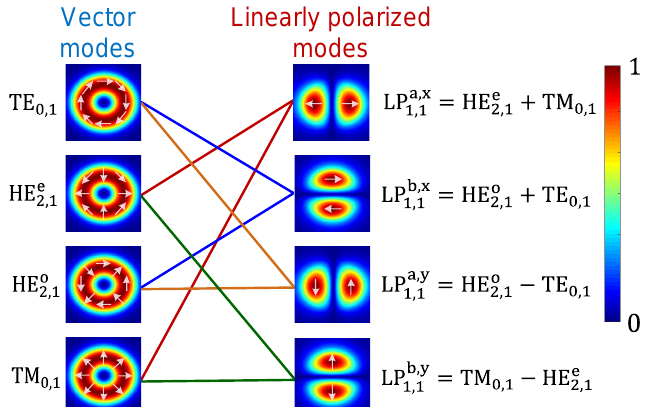
Figure 3. Intensity patterns of the first higher-order mode group in a SI-CCF. Arrows show the polarization of the modal electric field. The left column shows the input exact vector modes, while the right column shows the resultant modes at the output end. Specific linear combinations of mode pairs in the left column, resulting in the variety of LP 1,1 modes, are shown by colored